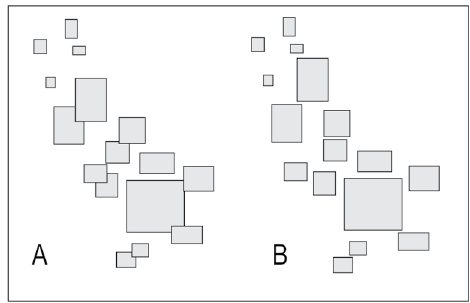
Fig. 5. Noncontiguous diagram cartogram – location of units: A – overlapping, B –